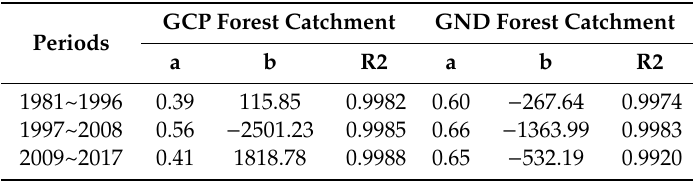
Table 4. Linear relations between cumulative rainfall ( and GND forest catchments (